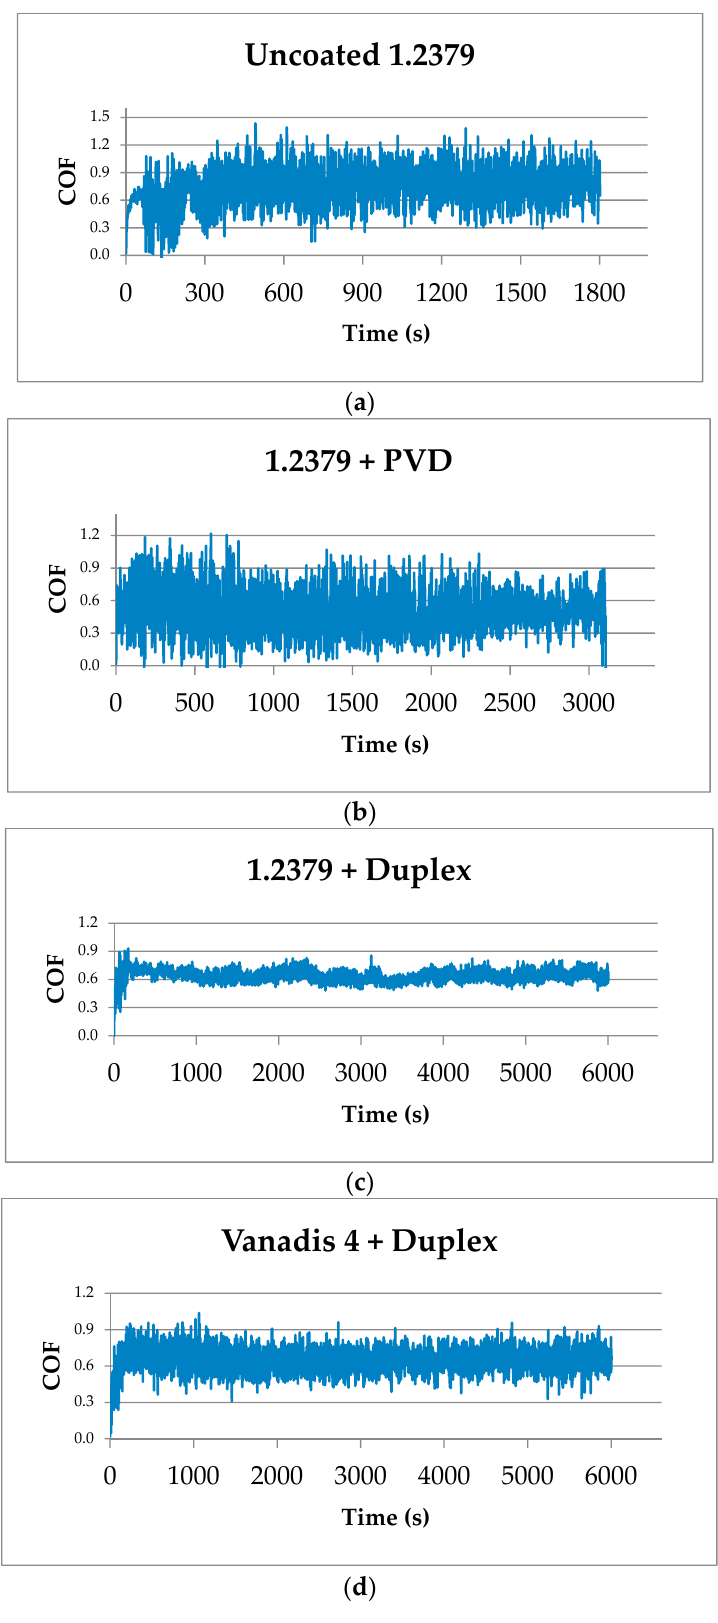
Figure 8. Friction coefficient (COF) test results for the uncoated 1.2379 sample ( a ), 1.2379 + PVD sample ( b ), 1.2379 + Duplex sample ( c ), and Vanadis 4 + Duplex sample ( d ).